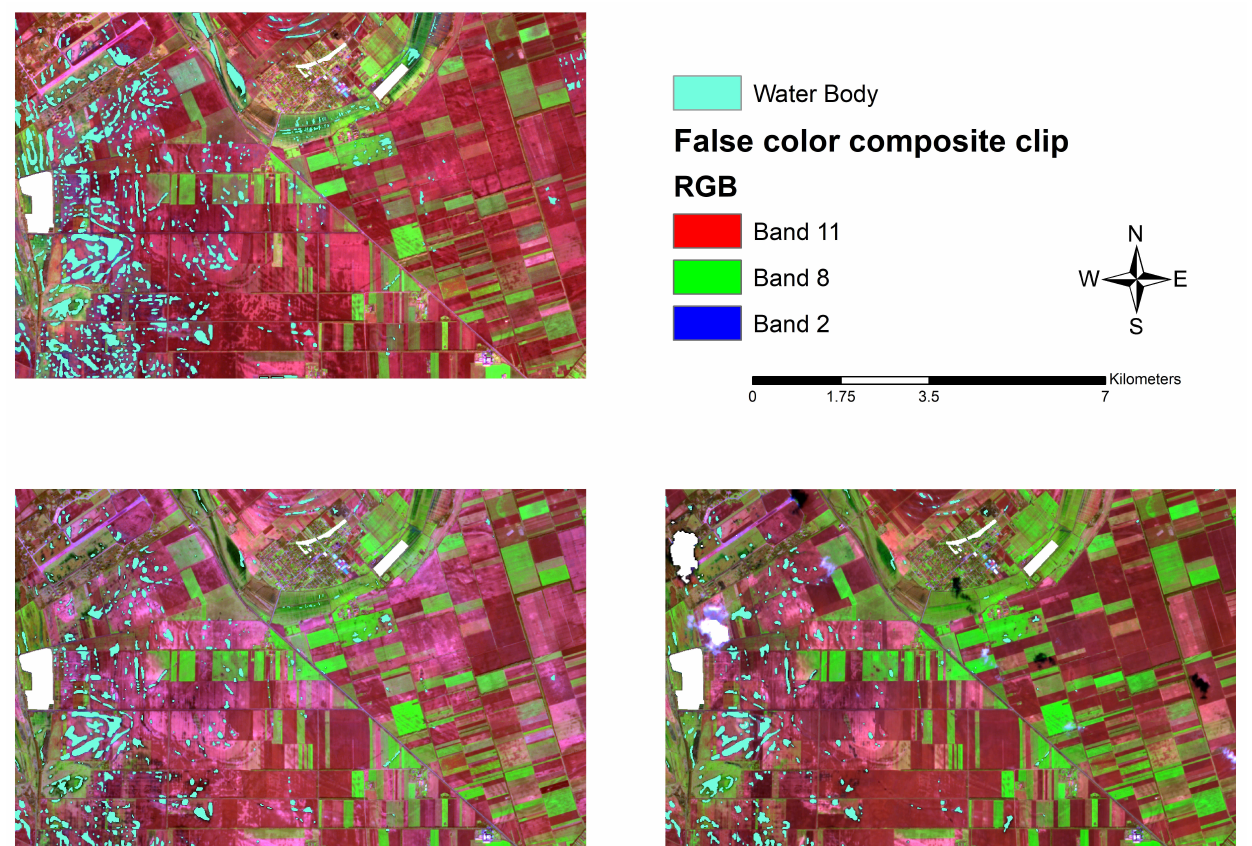
Figure 5. Manually digitized validation water polygons on the satellite images of the three dates (23 February 2021 ( upper left ); 7 March 2021 ( lower left ); 20 March 2021 ( lower right )).